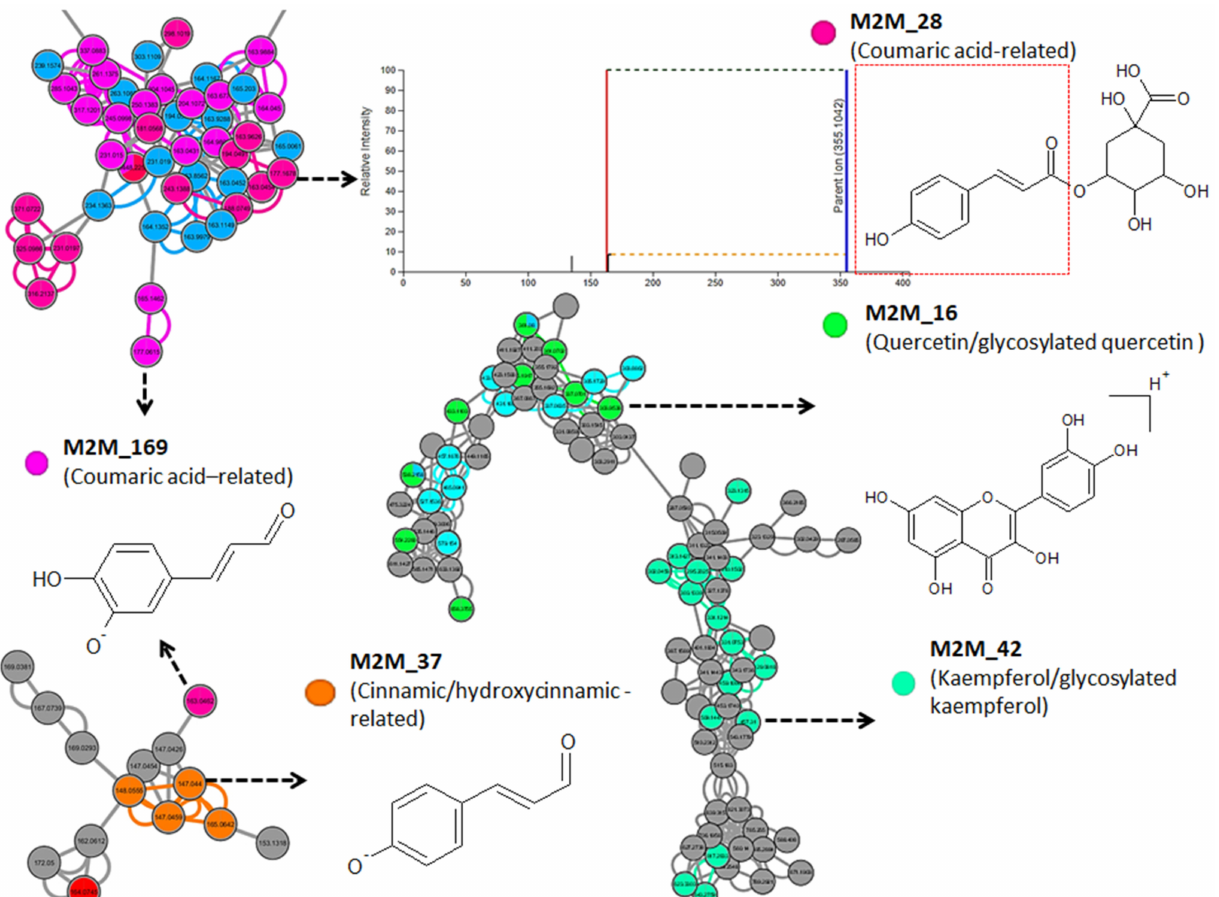
Figure 3. Characterized Mass2Motifs mapped on the spectral molecular network of the positive electrospray ionization (ESI+) MS/MS spectra obtained from maize leave extracts. Colored nodes represent the distinct Mass2Motif annotations and their occurrence within the spectra dataset. The shared Mass2Motifs among the various nodes were mapped on the edges connecting the